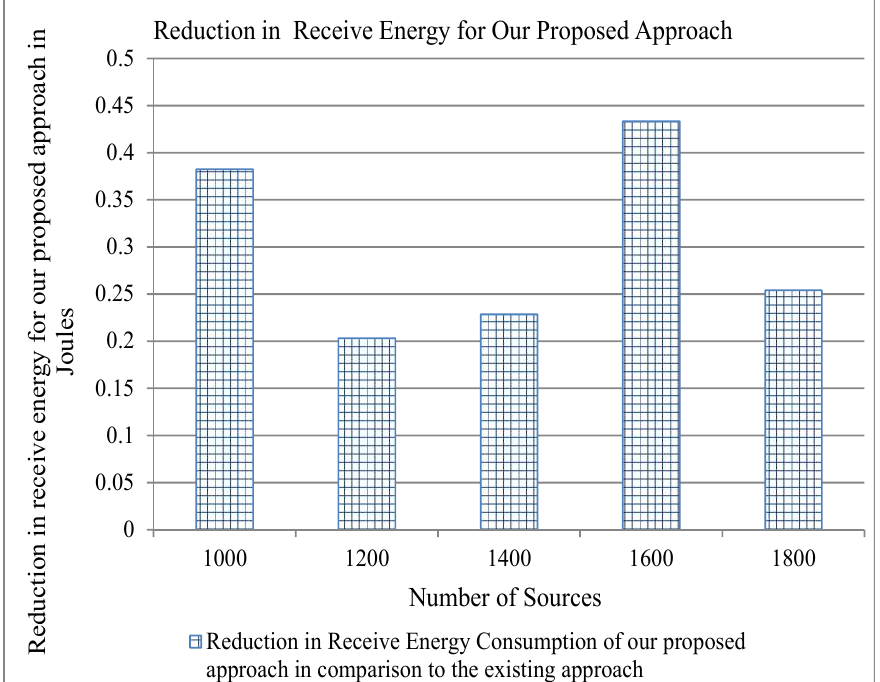
Figure 11. Reduction in Receive Energy for our proposed approach in comparison to the existing for three cache servers.